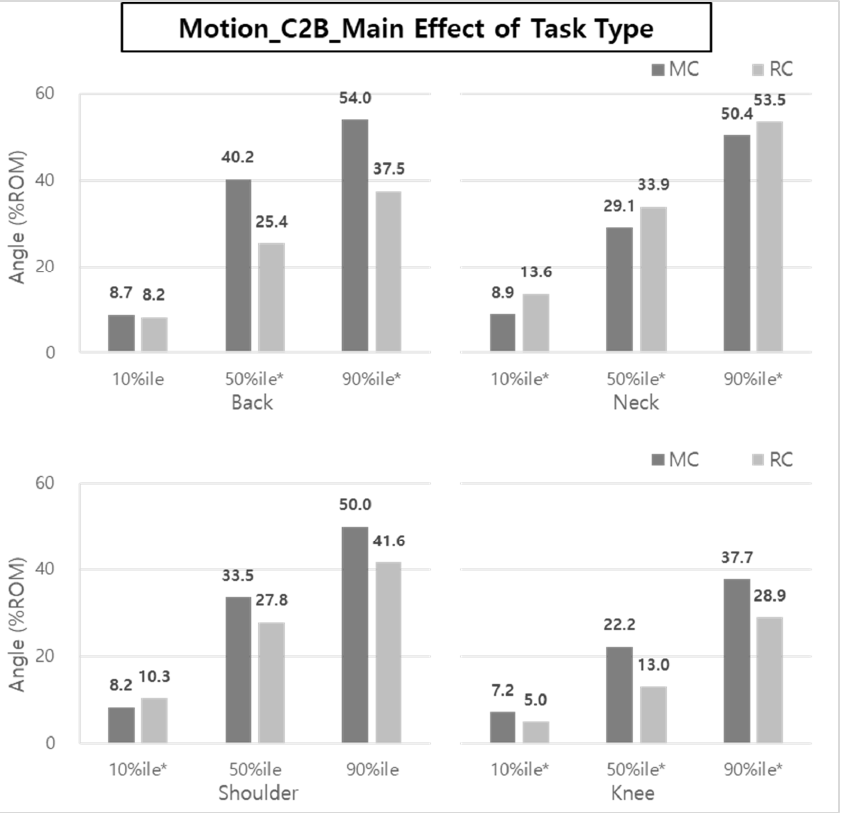
Figure 15. The effect of task type on body posture during C2B. Asterisk (*) indicates that the differ- ence between means is statistically significant at p < 0.05. between means is statistically significant at p <